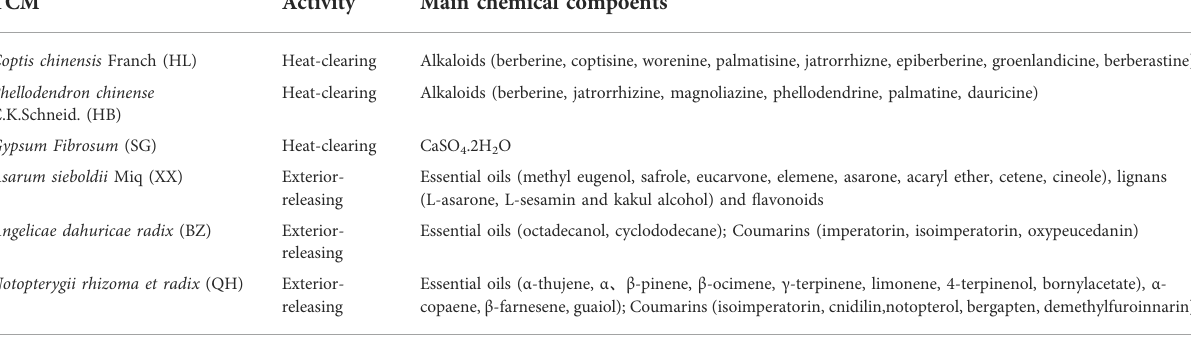
TABLE 1 Main chemical components of the tested heat-clearing and exterior-releasing TCMs. TCM